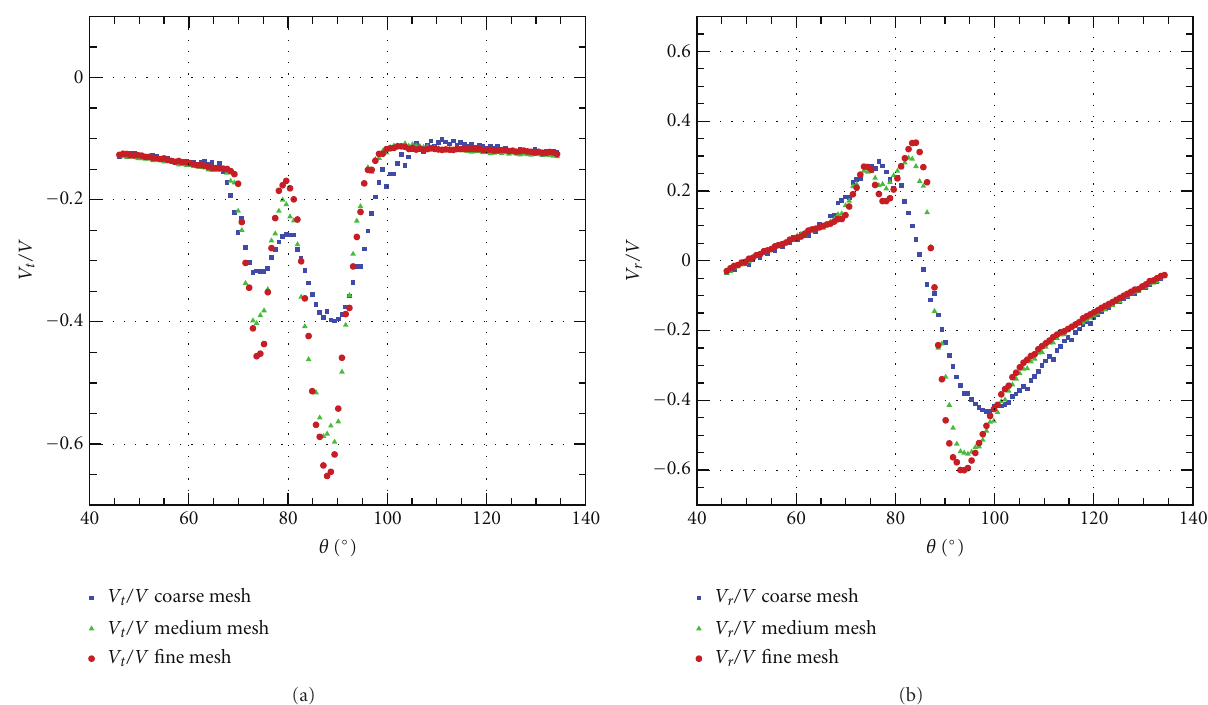
Figure 9: Convergence of radial and tangential nondimensional velocity distribution at x/R = 0.56, r/R = 0.90 aft the propeller